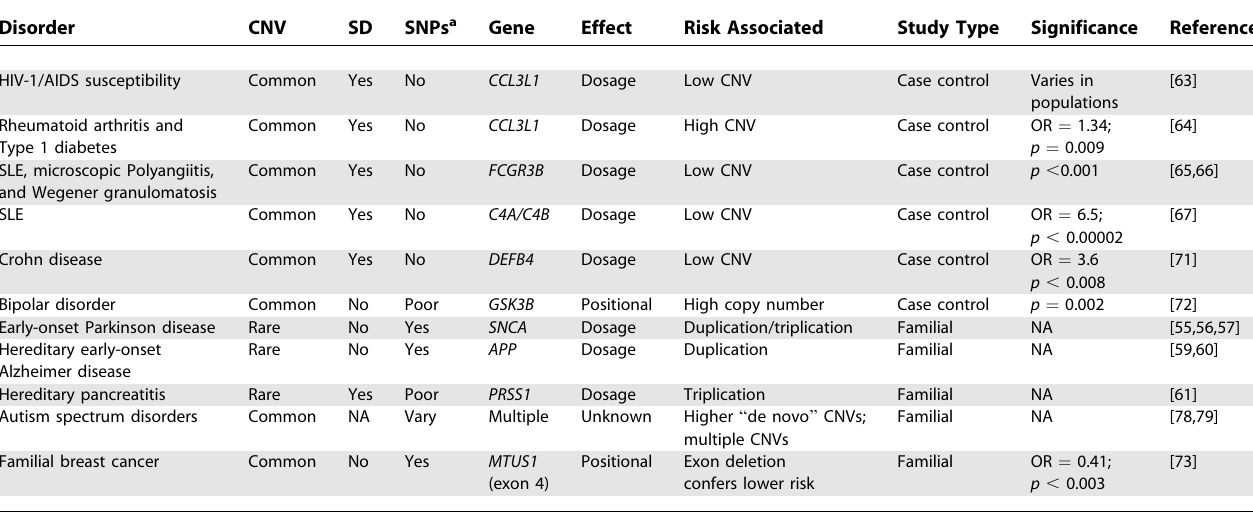
Table 3. Summary of Common Disorders for Which Associations to CNVs Have Been Reported Disorder